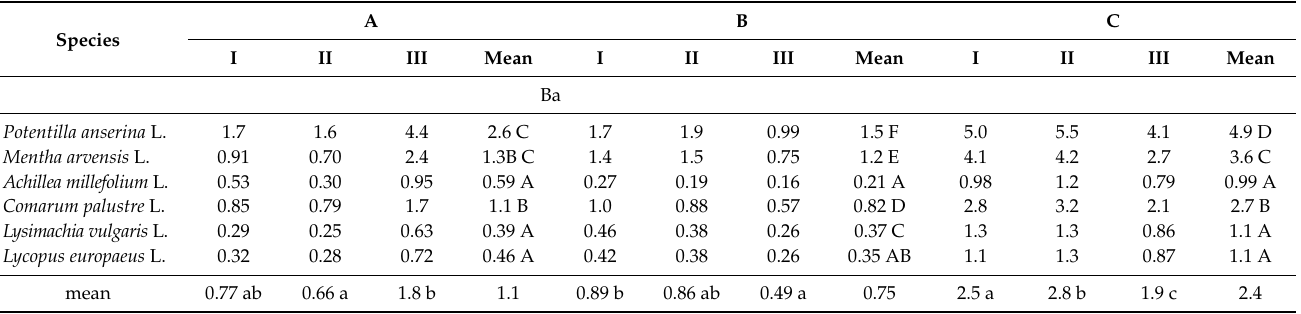
Table 6. Ba accumulation coefficient in the plants.